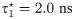
Bi-exponential parameter estimation at low photon counts.The uncertainty, as measured by the standard deviation of the estimated parameter distribution, in the bi-exponential decay parameter estimates obtained using ML, LS, and Bayesian analysis for the analysis of synthetic data simulating a bi-exponential decay (τ1⋆=2.0ns, τ2⋆=0.5ns, A1⋆=A2⋆) for a range of intensities between 103 and 104 photon counts. In (a) and (c) the fractional errors in the estimated decay lifetimes versus photon count; in (b) and (d) the fractional errors in the initial amplitudes of the two decay components. In all cases, the normalised width is displayed only when the respective estimates are not biased by more than 5% of the true value.